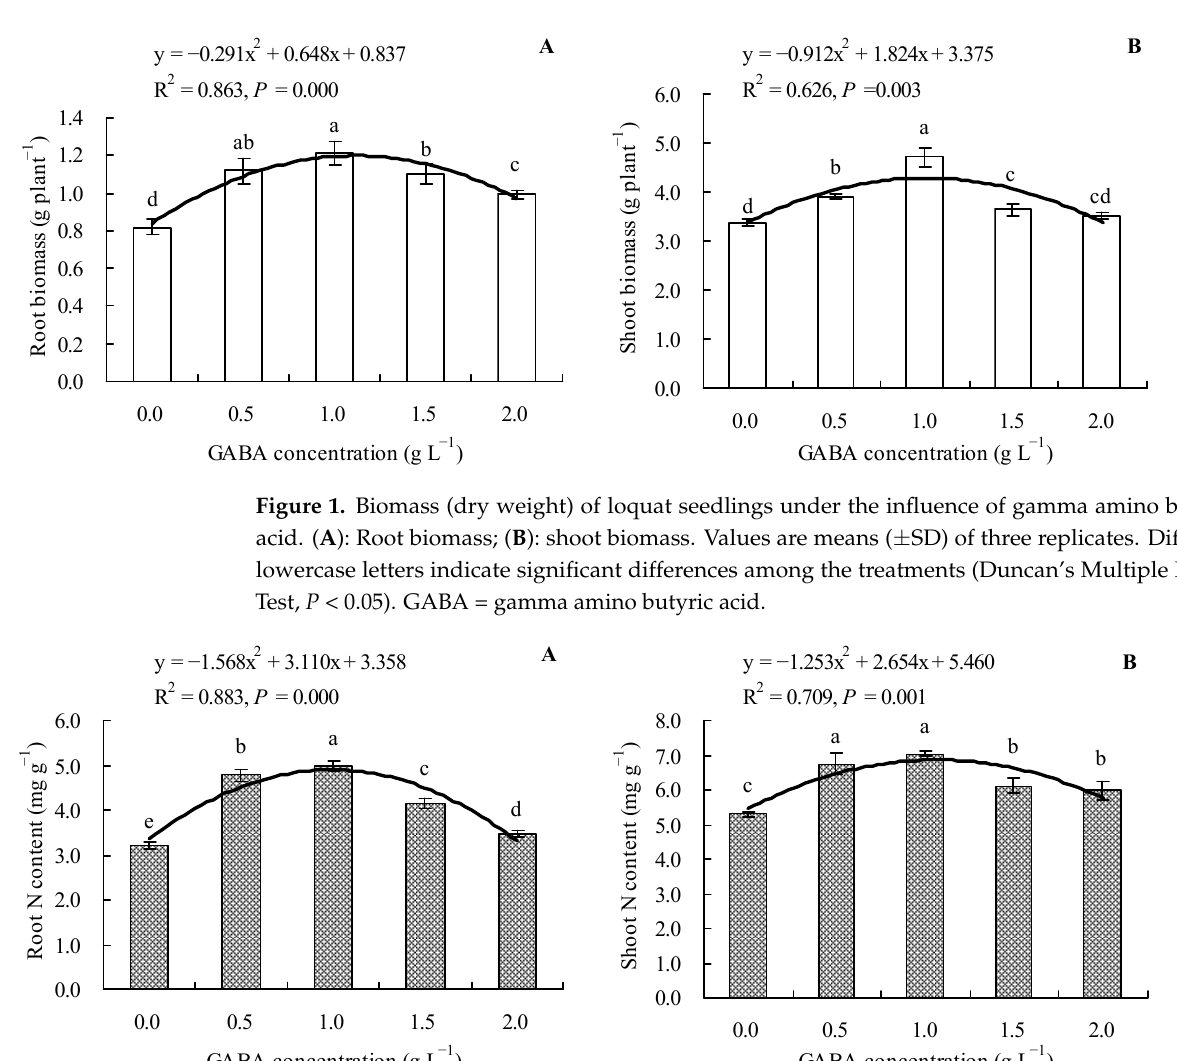
Table 1. Photosynthetic pigment content in loquat seedling leaves under the influence of gamma amino butyric acid.